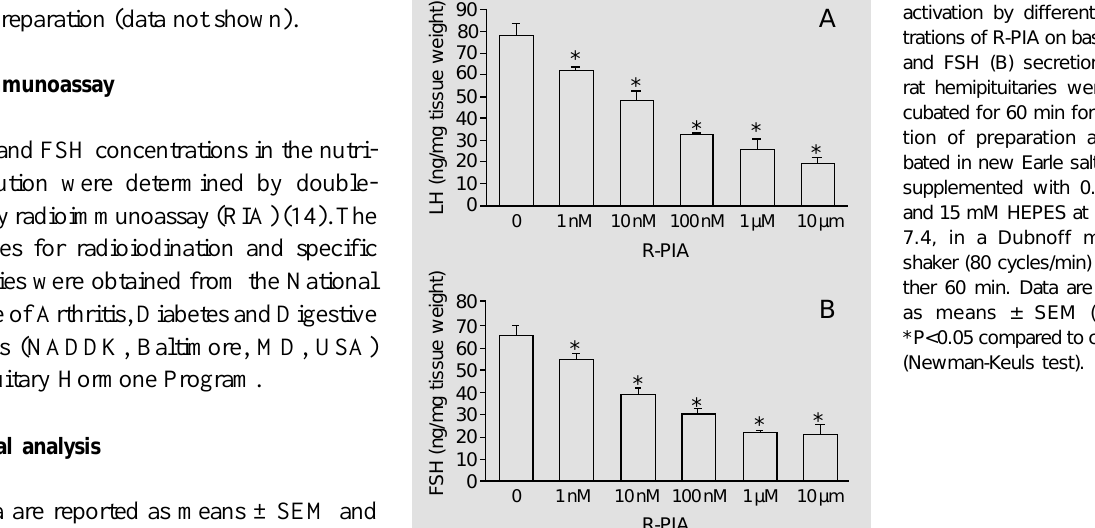
Figure 1 - Effects of A 1 receptor activation by different concen- trations of R-PIA on basal LH (A) and FSH (B) secretion. Wistar rat hemipituitaries were pre-in- cubated for 60 min for stabiliza- tion of preparation and incu- bated in new Earle salt solution supplemented with 0.1% BSA and 15 mM HEPES at 37 o C, pH 7.4, in a Dubnoff metabolic shaker (80 cycles/min) for a fur- ther 60 min. Data are reported as means ± SEM (N = 5). *P<0.05 compared to control (0) (Newman-Keuls